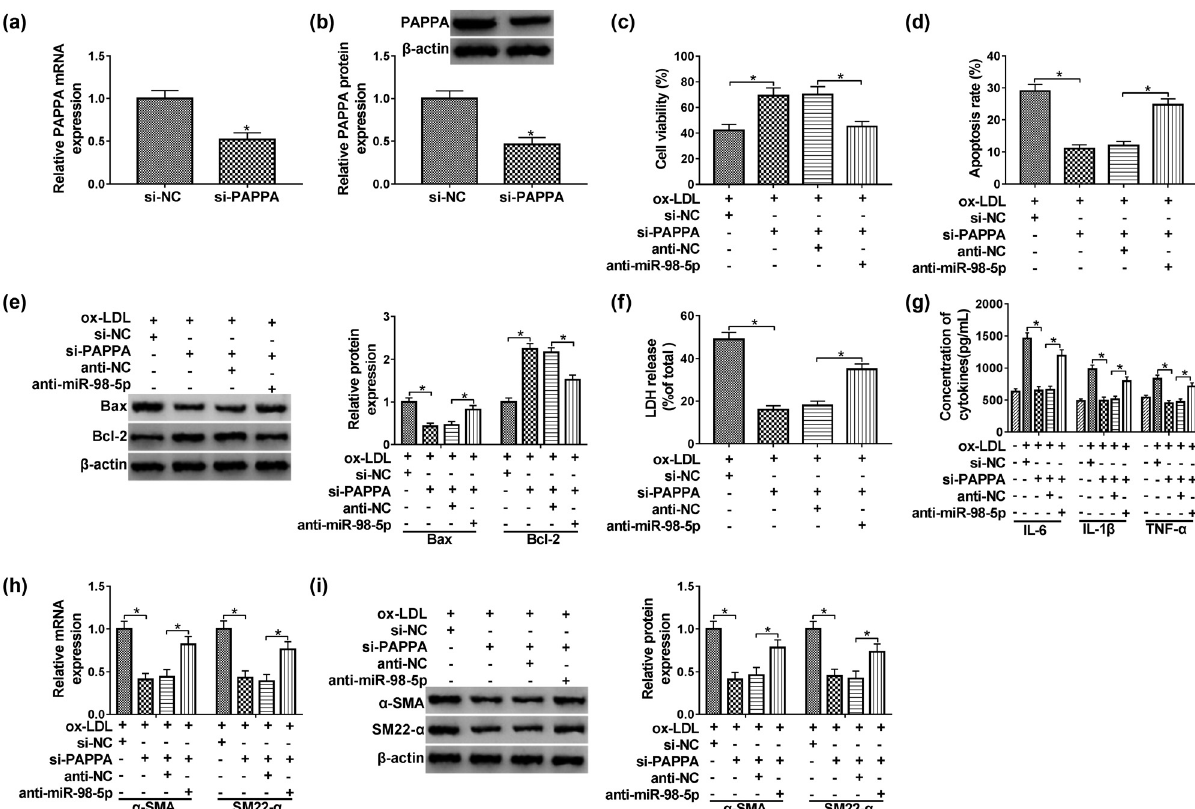
Figure 6: Knockdown of miR - 98 - 5p reversed si - PAPPA induced the e ff ect on proliferation, apoptosis, and in fl ammatory response in HUVECs. ( a and b ) The interference e ffi ciency of si - PAPPA in HUVECs was measured using qPCR and western blot assays. ( c – f ) HUVECs were treated with ox - LDL + si - NC, ox - LDL + si - PAPPA, ox - LDL + si - PAPPA + anti - NC, or ox - LDL + si - PAPPA + anti - miR - 98 - 5p. ( c ) The cell viability of HUVECs was estimated by MTT assay. ( d ) Apoptosis analysis was performed in HUVECs using fl ow cytometry assay. ( e ) The western blot assay was carried out to analyze Bax and Bcl - 2 expression in HUVECs. ( f ) The LDH detection kit was used to test LDH release in HUVECs. ( g ) ELISA assay was applied to measure the levels of IL - 6, IL - 1 β , and TNF - α in the medium, with 0 μ g/mL of ox - LDL group as control. ( h and i ) The expression levels of α - SMA and SM22 - α in HUVECs were assessed by qPCR and western blot assays. Data shown are mean ± SD and from three independent experiments. * P <